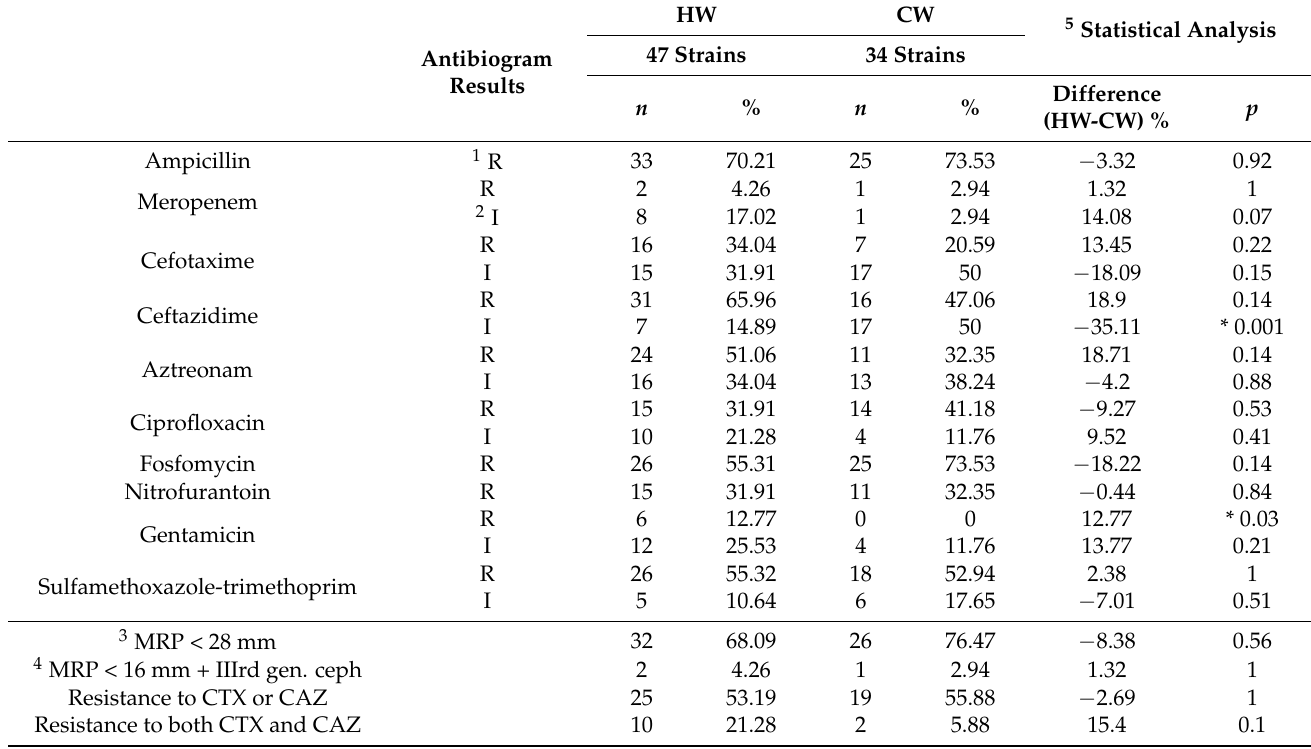
Table 1. Antibiotic resistance patterns for E. coli isolates from hospital wastewater (HW) and community wastewater